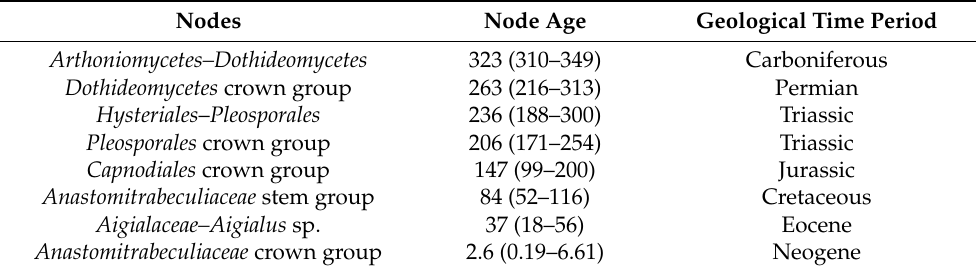
Table 2. Divergence time estimates obtained from BEAST analysis. The median and the 95% Highest Posterior Density are provided in million years ago (MYA). The geological time scales are given based on the median node age. Nodes Node Age